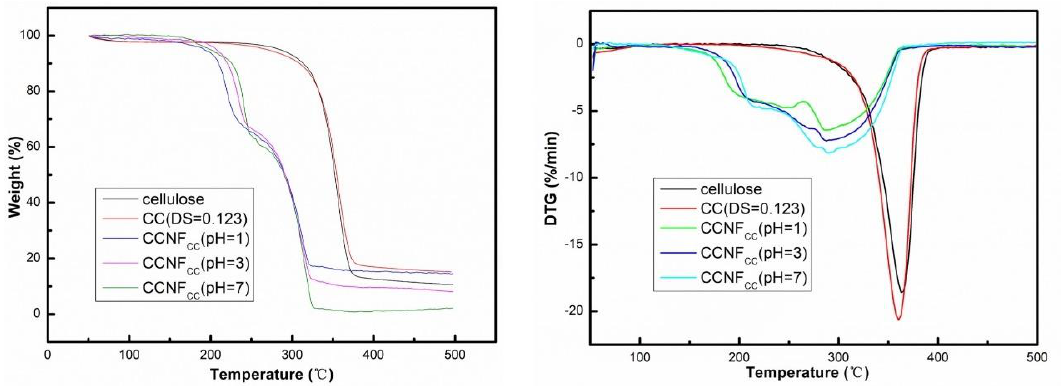
Figure 6. TG/DTG curves of the original cellulose, cellulose carbamates (DS = 0.123).